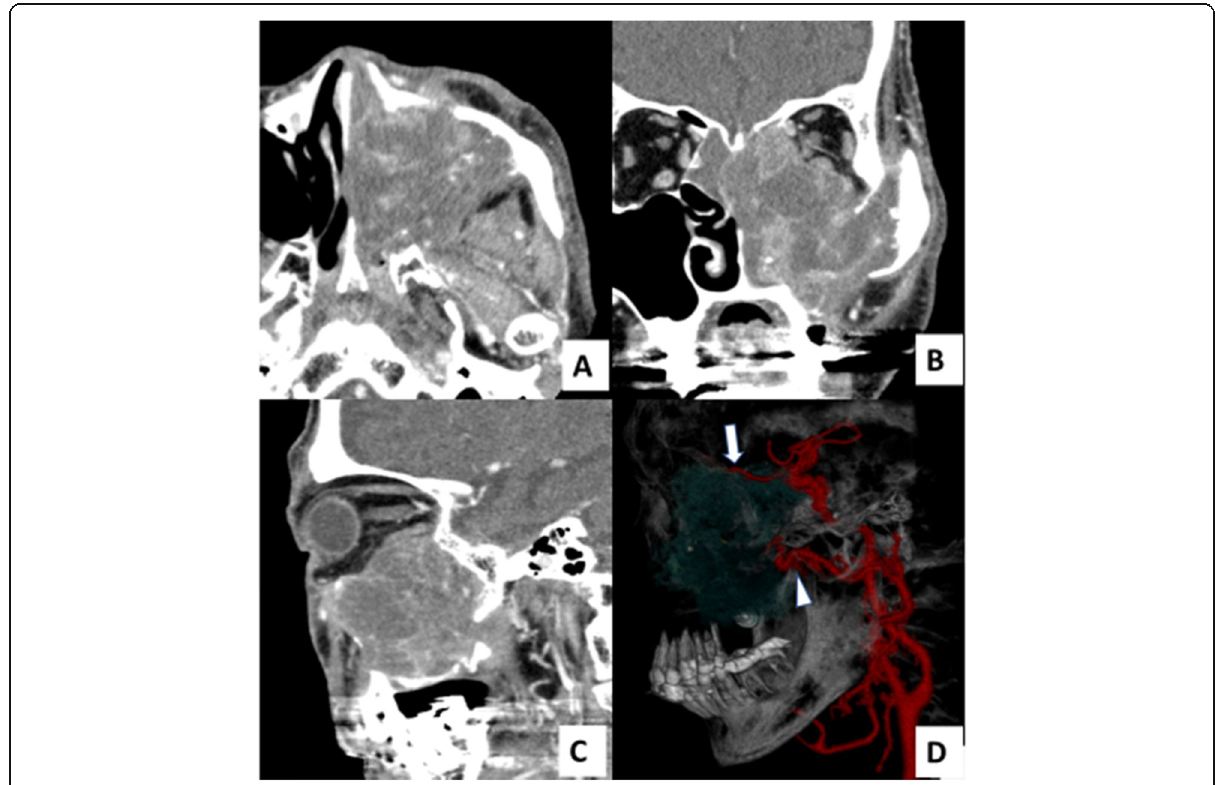
Fig. 1 Imaging of recurrent left maxillary carcinoma. A head and neck contrast-enhanced computed tomography showed an irregularly demarcated mass with orbital invasion. a Axial image; b Coronal image; c Sagittal image. d Feeding artery was suspected to involve the ophthalmic artery (white arrow) as well as the maxillary artery (white